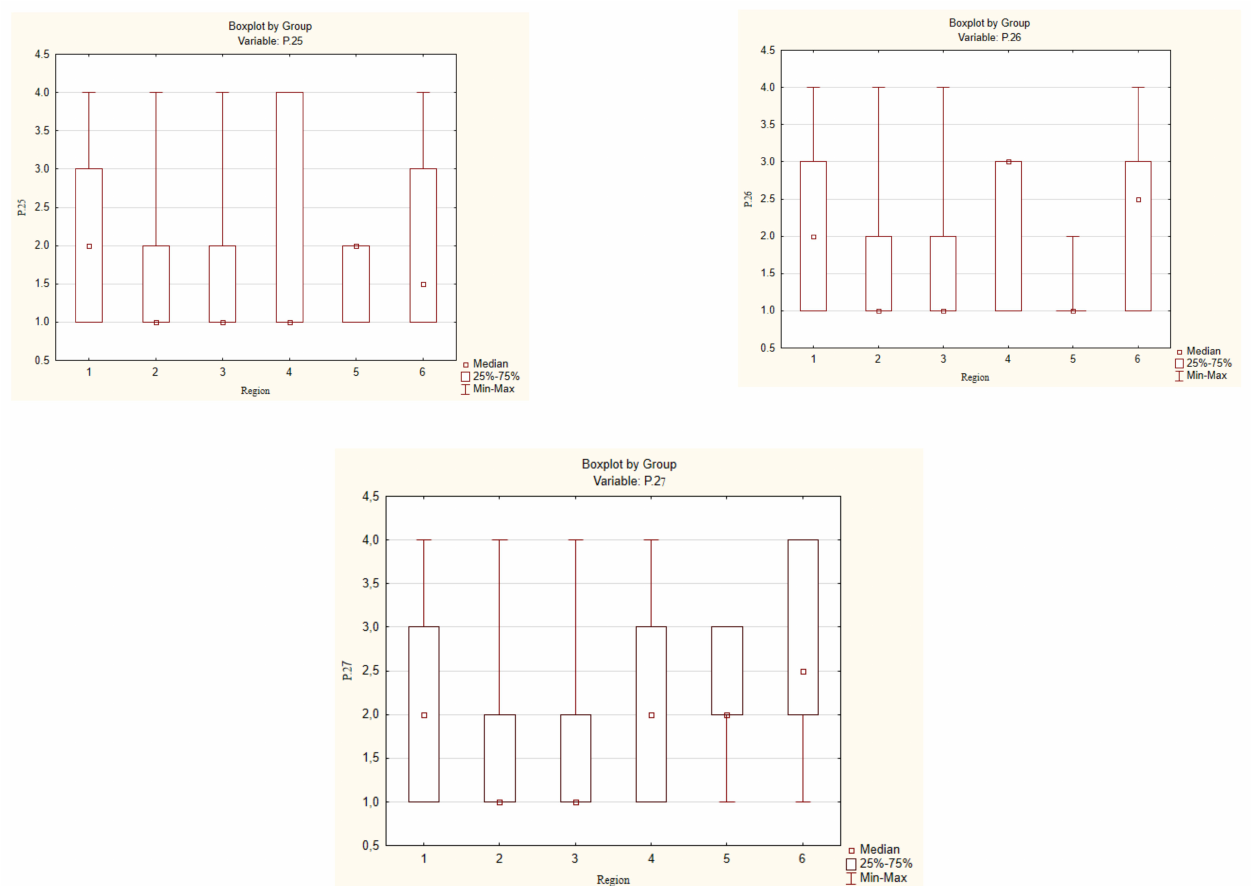
Figure 10. Box and whisker diagrams for practices P25 (Collection and delivery of glass containers to appropriate collection points), P26 (wastepaper collection and delivery to appropriate collection points) and P27 (Collection and delivery of used batteries, light bulbs to appropriate collection points) from the category “Waste management”.